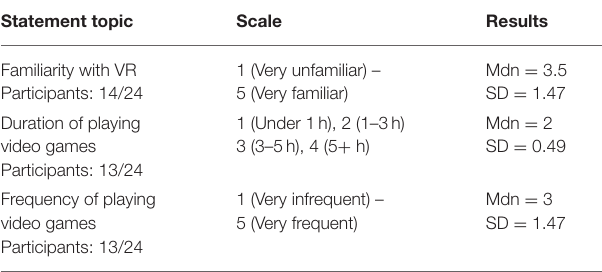
TABLE 1 | Demographics questionnaire